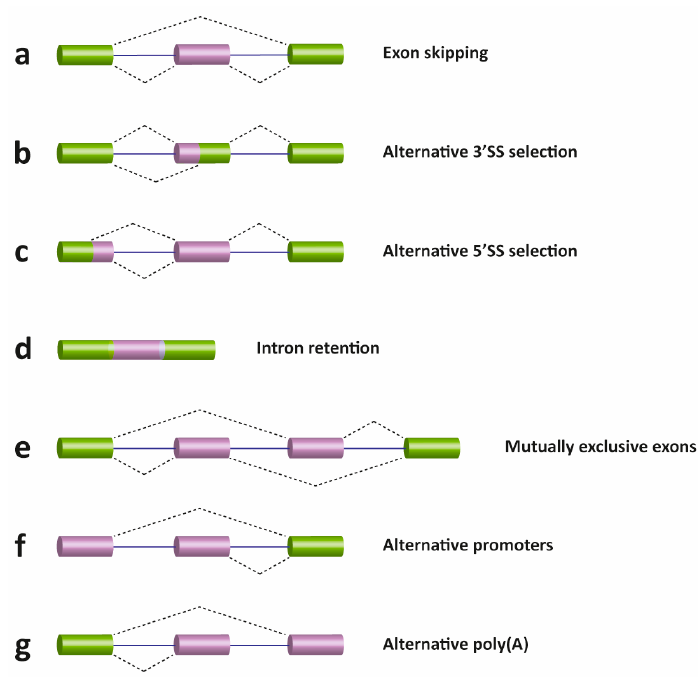
Figure 3. Schematic representation of different types of alternative transcriptional or splicing events, with exons (boxes) and introns (lines). Constitutive exons are shown in green and alternatively spliced exons in purple. Dashed lines indicate the AS event. Exon skipping ( a ); alternative 3 ′ ( b ) and 5 ′ SS selection ( c ); intron retention ( d ); mutually exclusive exons ( e ); alternative promoter usage ( f ); and alternative polyadenylation ( g ) events are shown. Like alternative splicing (AS), usage of alternative promoter and polyadenylation sites allow a single gene to encode multiple mRNA transcripts.